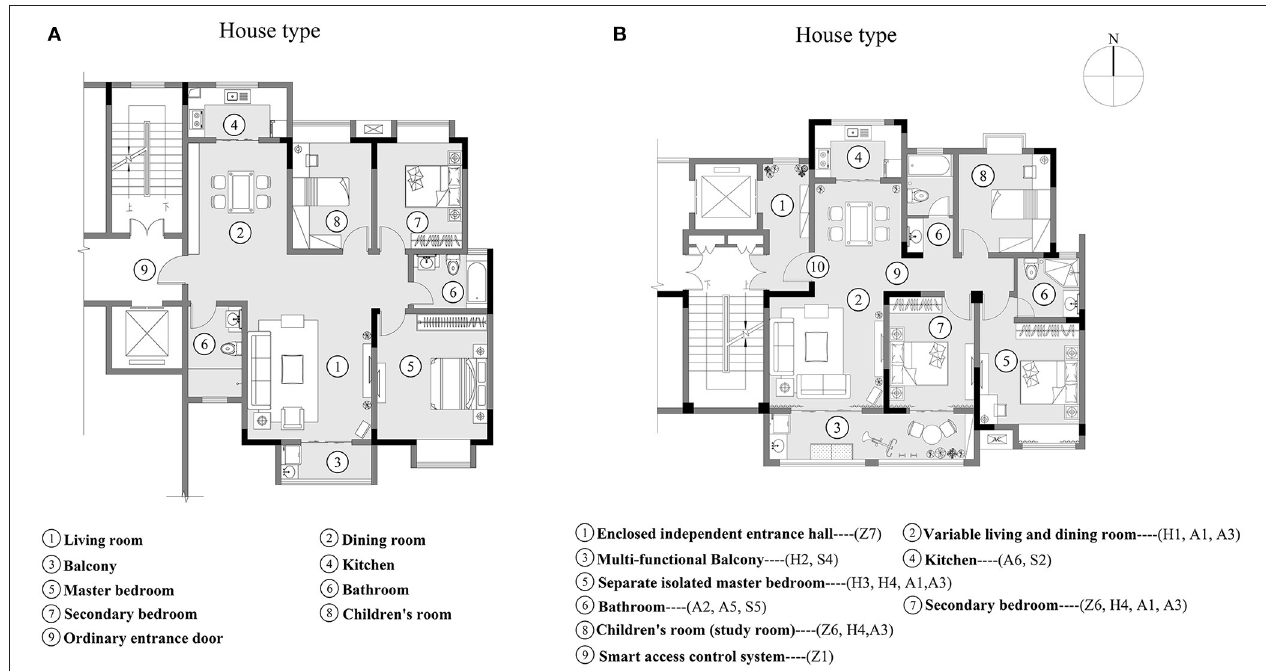
FIGURE 4 | Two housing units [Type (A) and Type (B) ] for preference survey.